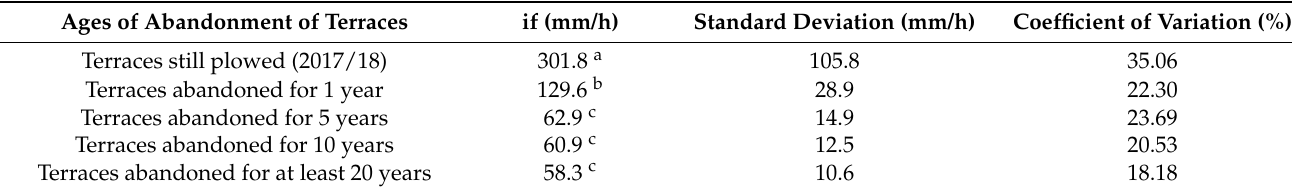
Table 5. Evolution of the average final infiltration capacity (if) according to the age of abandonment of the terraces in the villages of Tizerkine and Timzemzit, Ait Baha, Western Anti-Atlas, Morocco.